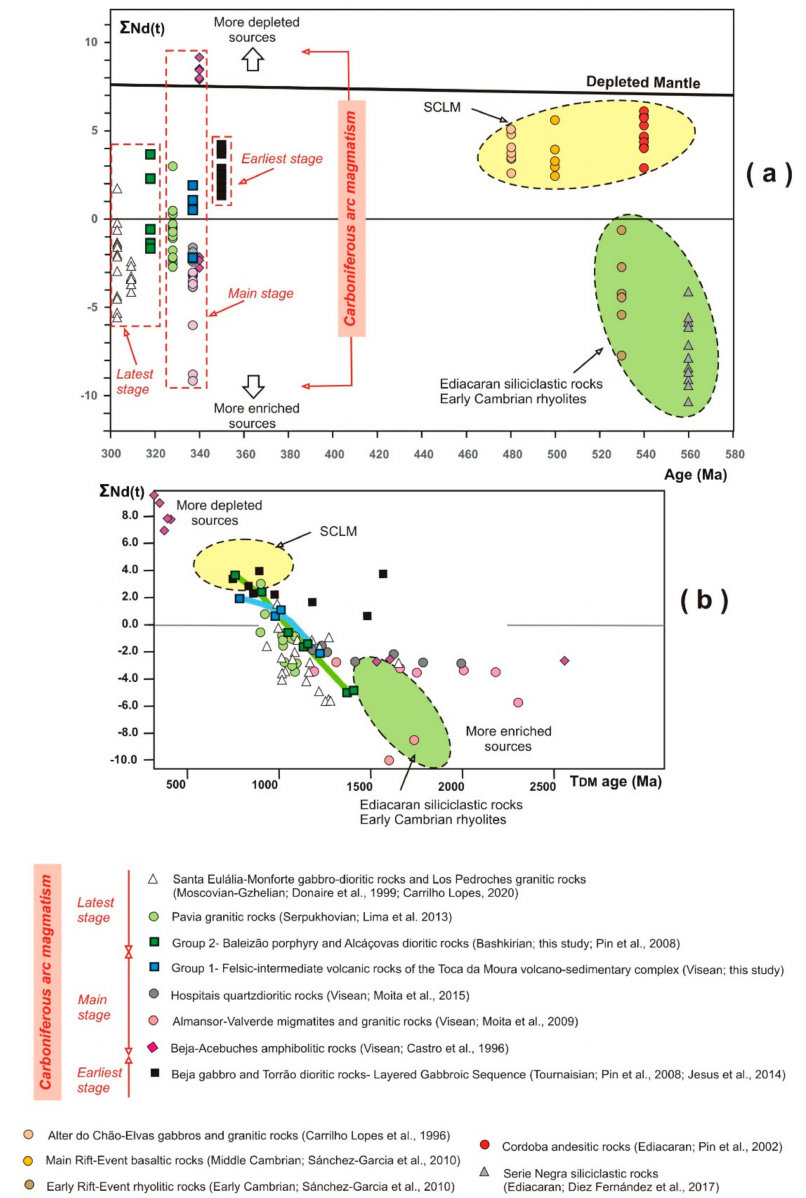
Figure 9. Compilation of bulk rock epsilon Nd values from Ossa-Morena Zone igneous and sedi- mentary rocks. SCLM-proxy for the isotopic composition of the SCLM beneath the Ossa-Morena Zone (see discussion in the text). ( a ) ε Nd vs. age and ( b ) ε Nd vs. T DM age diagrams for the Toca da Moura (Group 1) and Baleiz ã o-Alc á çovas (Group 2) igneous rocks and other relevant data from the Ossa-Morena